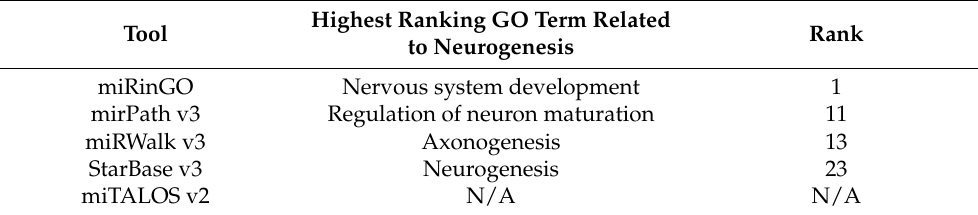
Table 3. Comparison of highest-ranking GO terms related to neurogenesis from different miRNA GO enrichment tools. Highest Ranking GO Term Related Rank Tool to Neurogenesis miRinGO Nervous system development 1 mirPath v3 Regulation of neuron maturation 11 miRWalk v3 Axonogenesis